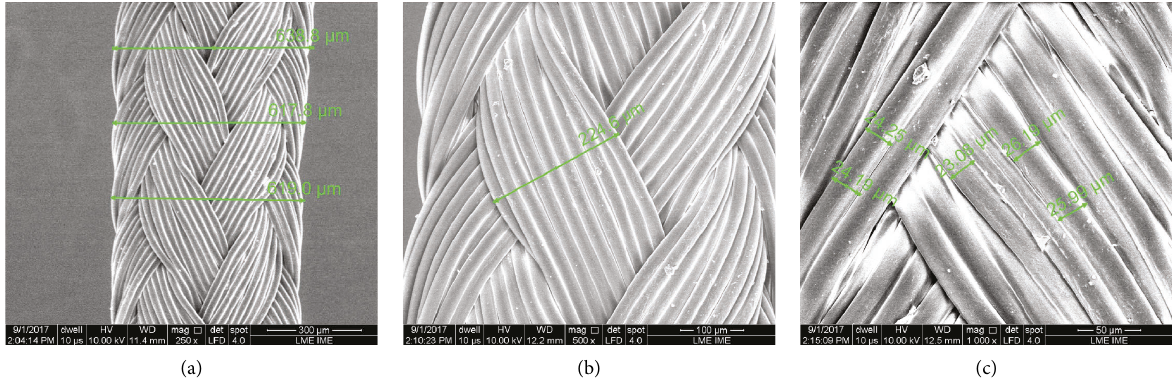
Figure 7: Morphologies of used thread at small magnification (a), wire rope (b), and thin wires (c).